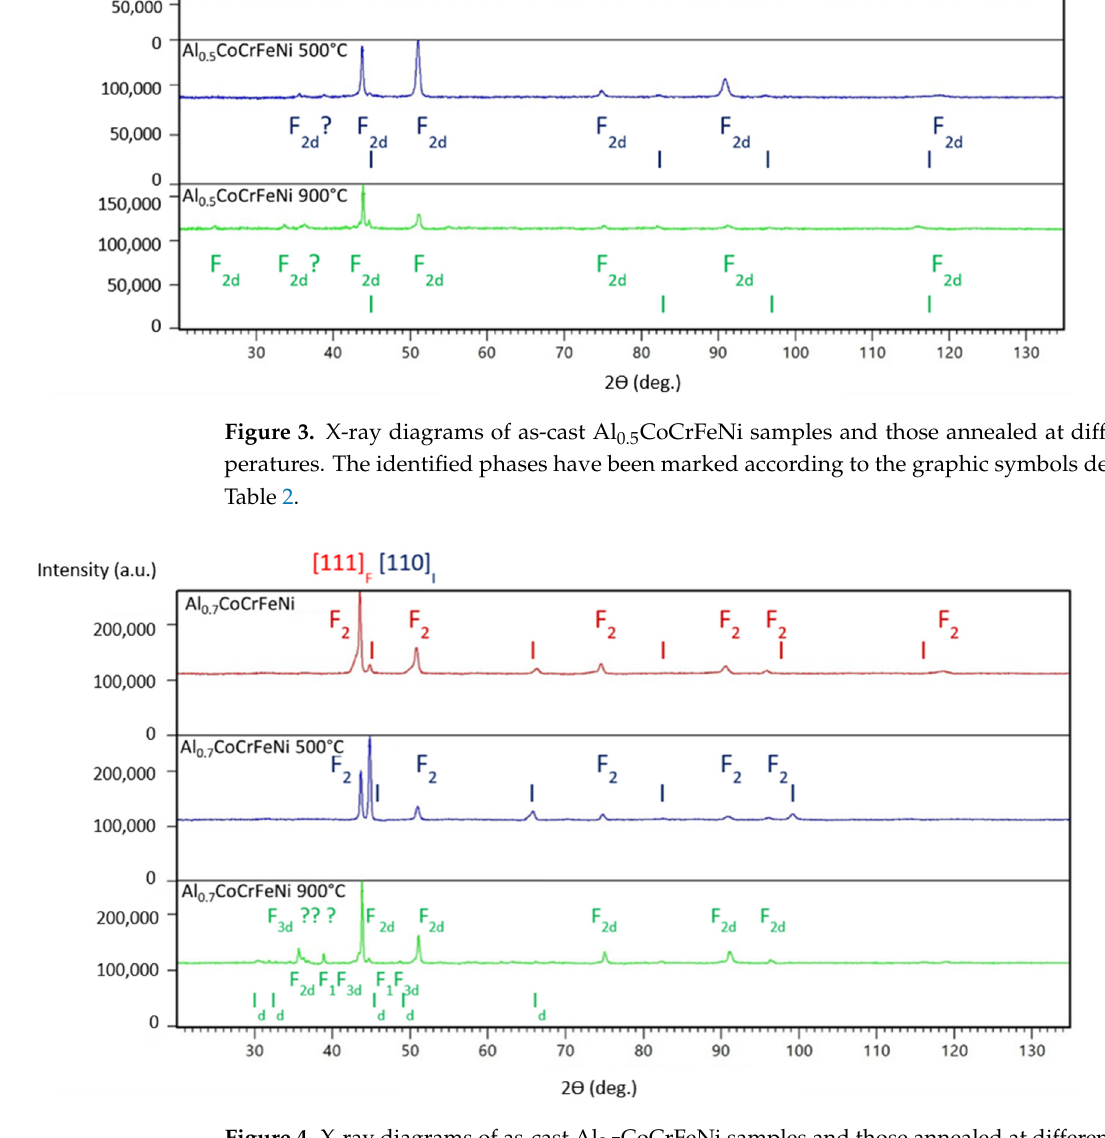
Figure 3. X ‐ ray diagrams of as ‐ cast Al 0 . 5 CoCrFeNi samples and those annealed at different temper ‐ atures. The identified phases have been marked according to the graphic symbols described in Table 2.